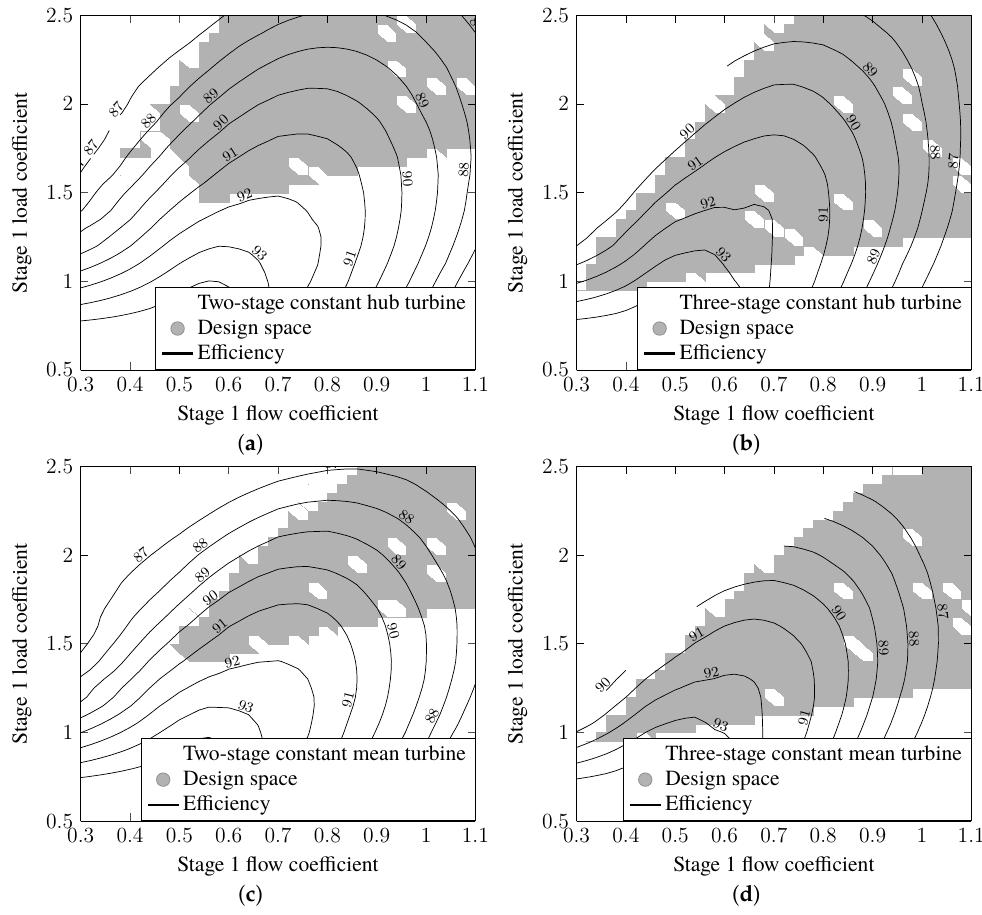
Figure 15. Comparison of the efficiencies of low-pressure turbine design maps: ( a ) constant hub, two stages; ( b ) constant hub, three stages; ( c ) constant mean, two stages; ( d ) constant mean, three